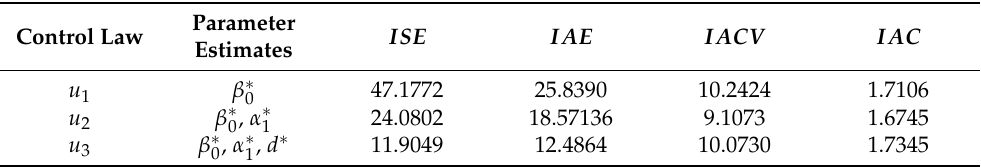
Table 10. Performance indexes using the LSOD method and a sine wave as excitation signal using the control laws